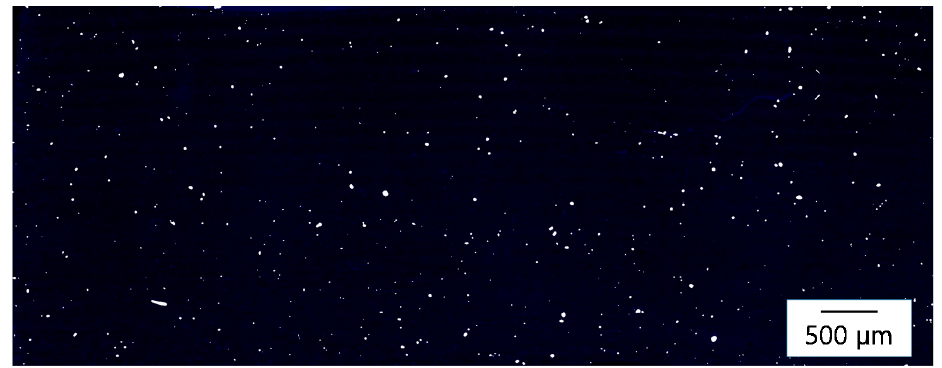
Figure 18. Typical fluorescence image (binarized) obtained by staining the cut surface of a CACNF/MAPP/PP composite (10/5/85 by weight) with CW. Reprinted with some modifications from Ref. [42]. Copyright Elsevier Ltd. (2020).